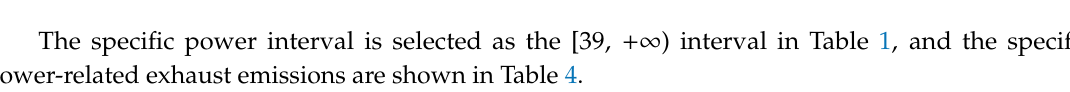
Table 4. Related specific power exhaust emissions.